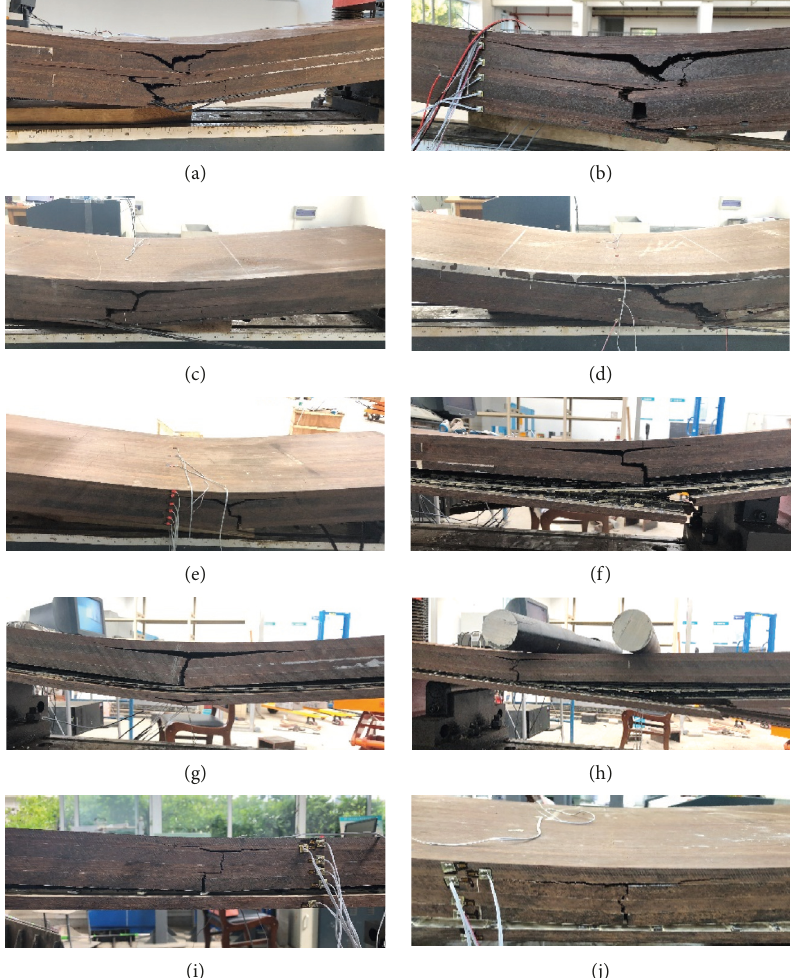
Figure 15: Failure modes of groups CLB-I and CLB-M. (a) CLB-I1. (b) CLB-I2. (c) CLB-I3. (d) CLB-I4. (e) CLB-I5. (f) CLB-M1. (g) CLB- M2. (h) CLB-M3. (i) CLB-M4. (j)